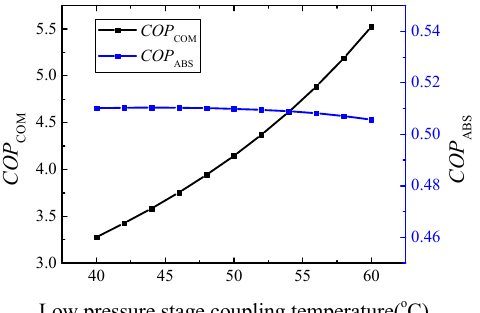
Figure 6. Effect of low pressure stage coupling temperature on sub-cycle COP. The COP of this hybrid cycle varies with the coupling temperature of the low-pressure stage, as shown in Figure 7. COP of the hybrid cycle increases from 2.30 to 3.03 when the coupling temperature changes from 40 ◦ C to 60 ◦ C, mainly due to the improvement in compression sub-cycle performance.